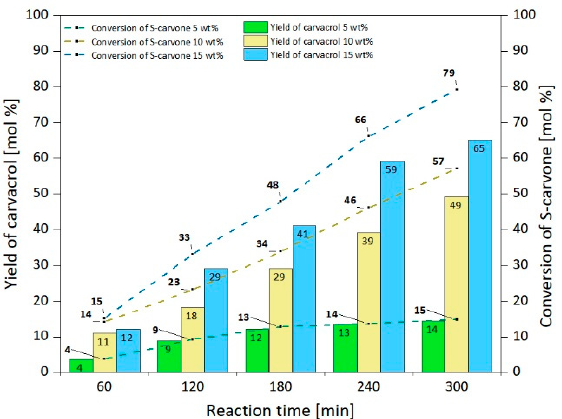
Figure 14. Influence of the reaction time and catalyst content on the conversion of S-carvone and the yield of carvacrol at 200 °C. (The experimental error was 1 mol%.)